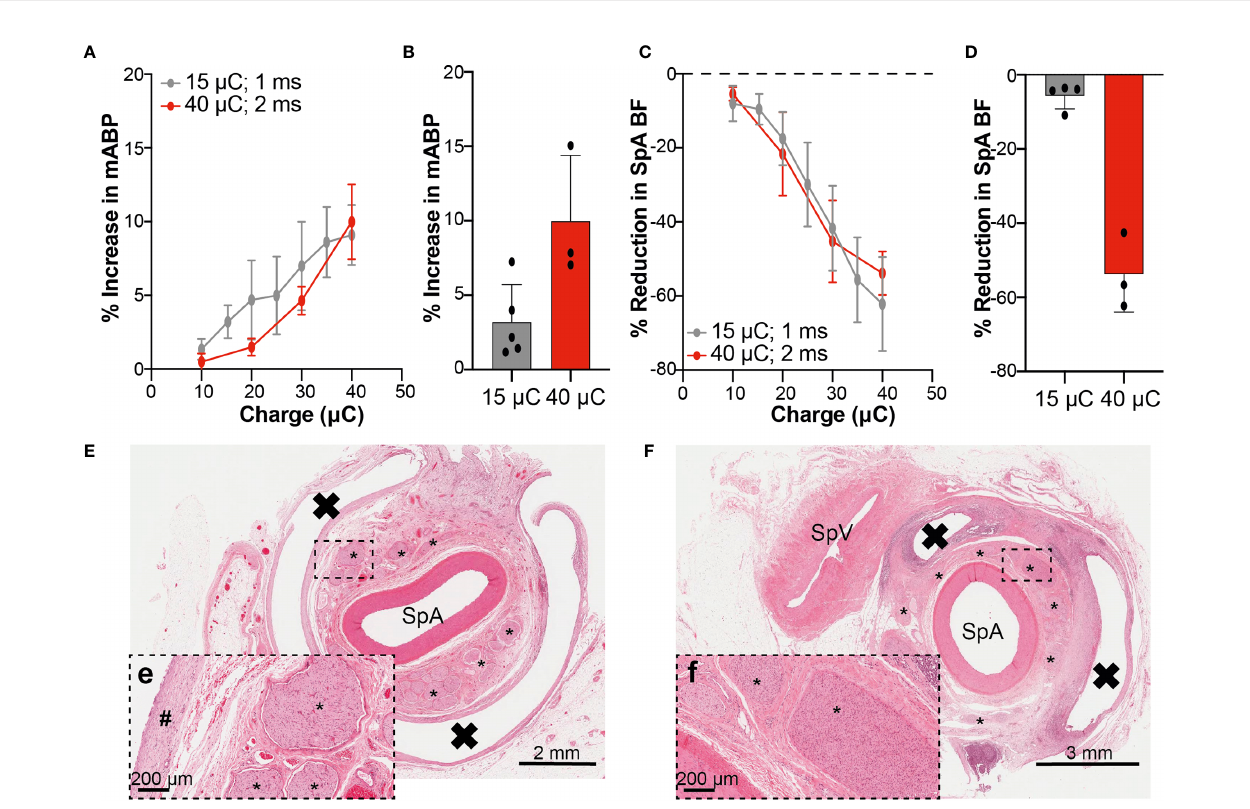
FIGURE 6 | Physiological and Histological Assessment Con fi rms Integrity of Electrode-Nerve-Spleen Circuitry at Termination. (A, C) Percentage changes (normalized to pre-stimulation baseline) in mABP (A) and SpA BF (C) obtained when stimulating the SpN with the implanted cuff at different intensities, using an external stimulator, up to 40 m C. The curves obtained with two different pulse widths (1 and 2 ms) are shown. (B, D) Graphs showing the maximum percentage changes in mABP and SpA BF achieved at termination at relevant IPG output (15 or 40 m C), delivered at 10 Hz continuously for 60 s. Data in A-D are shown as mean ± s.e.m. (E) Low power image of transverse section from the splenic artery from a representative animal. The SpA is surrounded by numerous fascicles with normal morphology. The white band encircling the artery and fascicles represents the former location of the implanted cuff. The black box highlights the region represented in (E-e; higher power image) and shows nerve fascicles with normal morphology. A band of mature fi brotic tissue is part of the fi brotic capsule surrounding the implant and represents an expected and acceptable response to the device. (F) Low power image of a transverse section from the splenic artery from a second representative animal. A more signi fi cant tissue response to the presence of the implanted cuff is observed here when compared to that seen in (E) . The SpA is surrounded by numerous fascicles. The white band surrounding segments of the artery and fascicles represents the former location of the implanted cuff. The black box highlights the region represented in (F-f; higher power image) and shows nerve fascicles with evidence of increased cellularity (Schwann cell hyperplasia) and perineural fi brosis and represents a localized chronic response to low level nerve injury. * = Nerve fascicle; # = mature band of fi brotic tissue, X = former location of implanted cuff, SpV, splenic